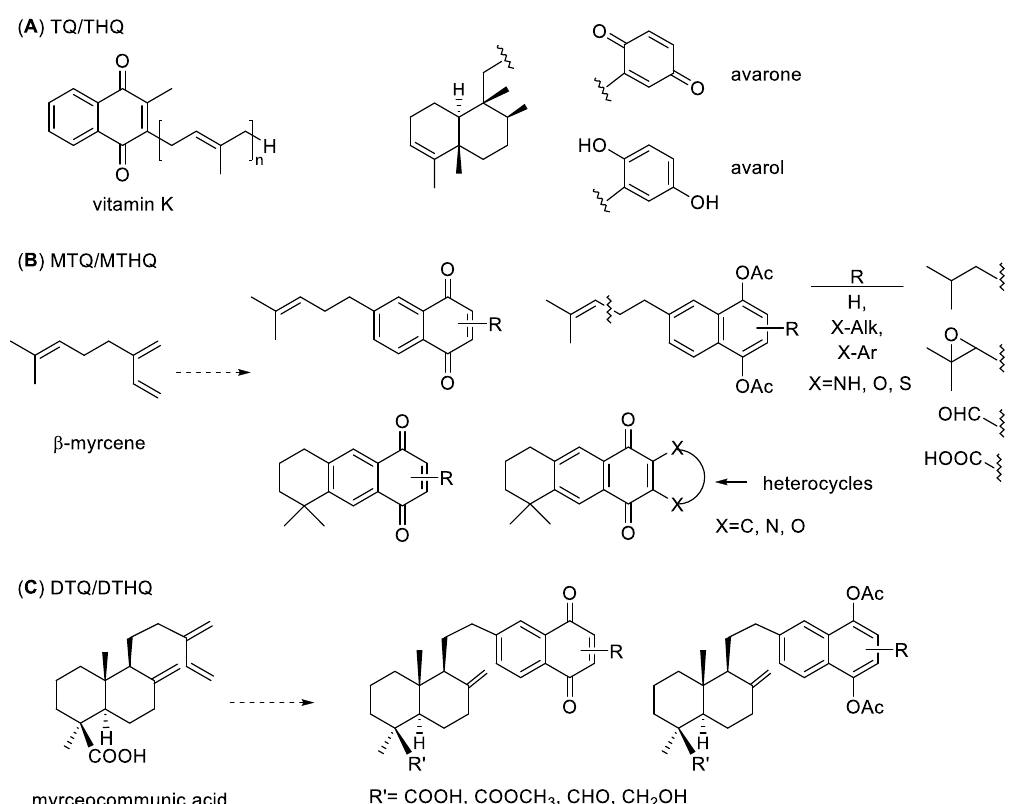
Figure 1. Structures of representative terpenylquinones (TQ) and terpenylhydroquinones (THQ). ( A ) Examples of natural TQs and THQs. ( B ) General structure of monoterpenylquinones/hydroquinones (MTQ/MTHQs) derived from β-myrcene. ( C ) General structure of diterpenylquinones/hydroquinones (DTQ/DTHQs) derived from myrceocommunic acid.